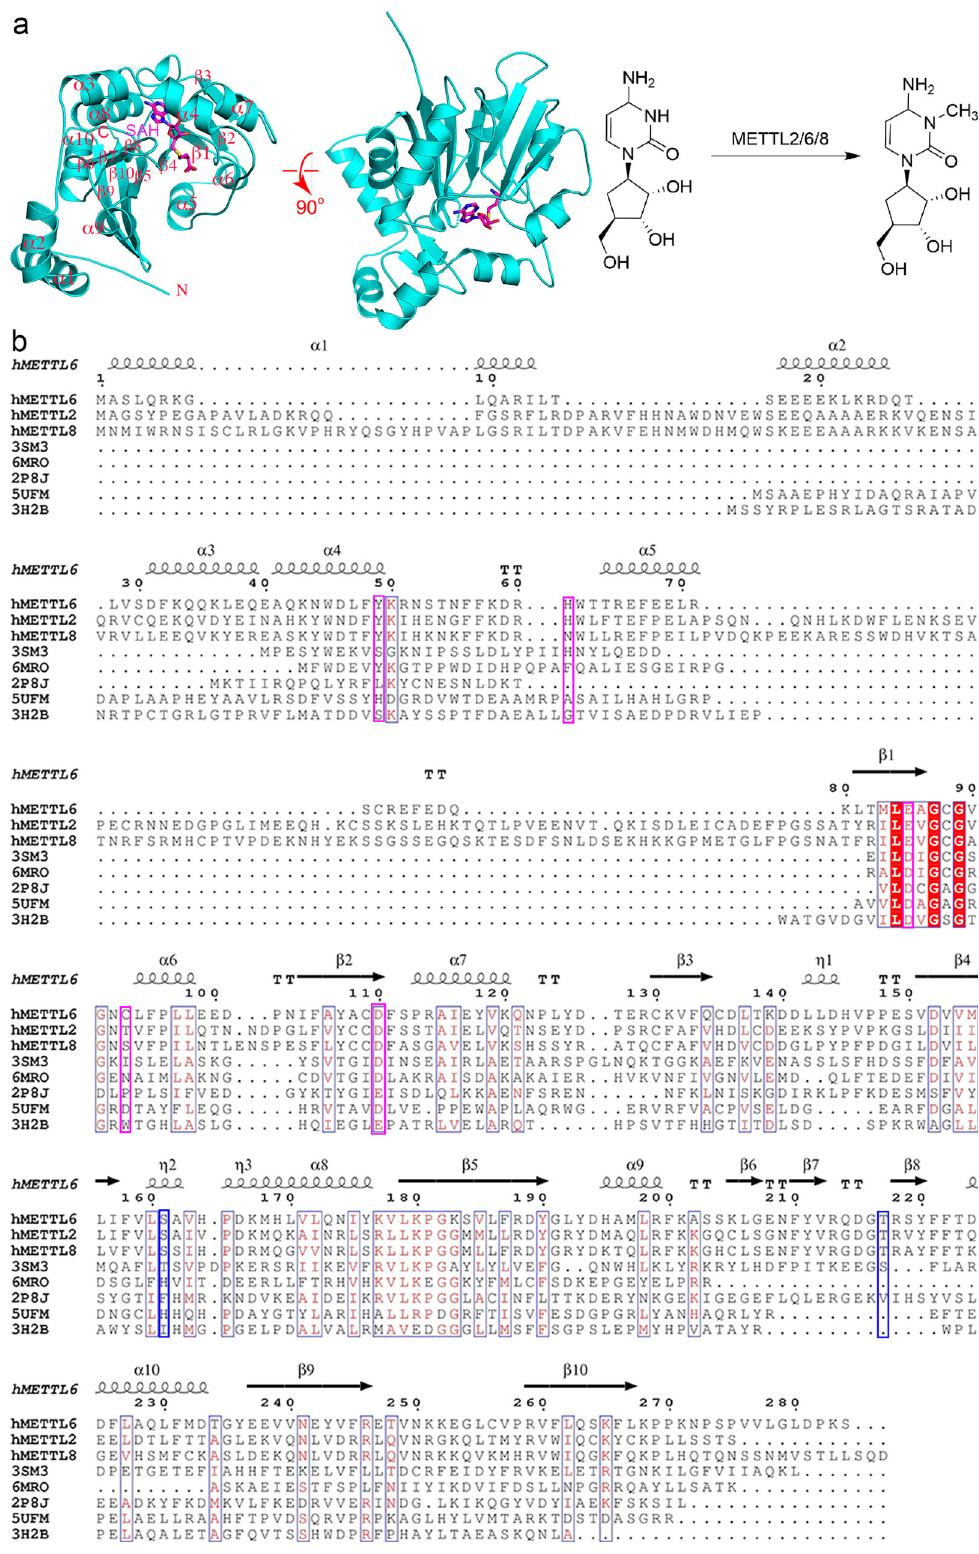
Fig. 1 The overall structure of hMETTL6. a The chemical reaction that hMETTL6 catalyzes and its structural basis. Left: the structure was shown in cartoon in two orthogonal views and the SAH ligand was shown as sticks. The N- and C-termini were indicated, and the helices were labeled. Right: the chemical reaction carried out by the METTL2/6/8 enzymes. b Multiple sequence alignment of hMETTL6 with orthologs and other published structures. The secondary structure elements were labeled above the sequences. The key residues for SAH contacts were indicated by the red arrows. The magenta boxes indicated the residues important for SAH binding, whereas blue boxes indicated the residues important for CMP